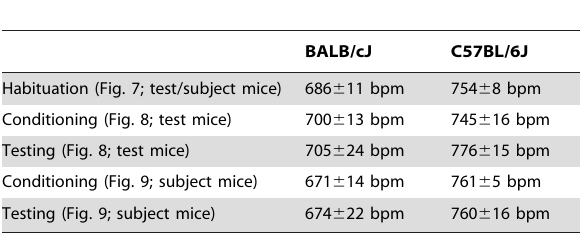
Table 2. Baseline heart rates of test/subject mice during different phases of the conditioning protocol.